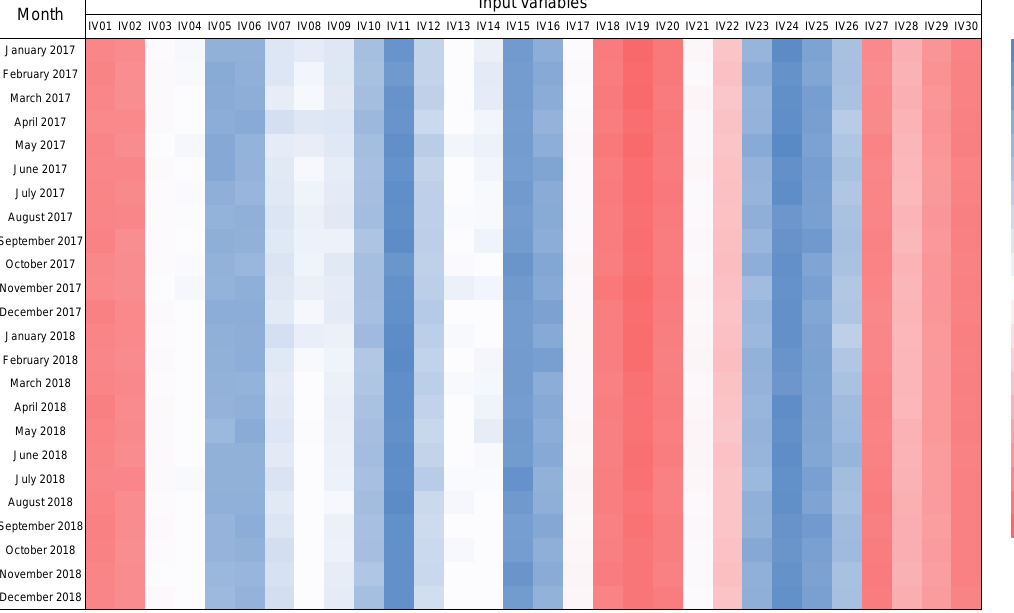
Figure 15. Result of feature importance via time-series cross-validation using the input variables in Table 2 for Gosan-ri. A cooler color indicates a lower feature importance value, whereas a warmer color indicates a higher feature importance value.